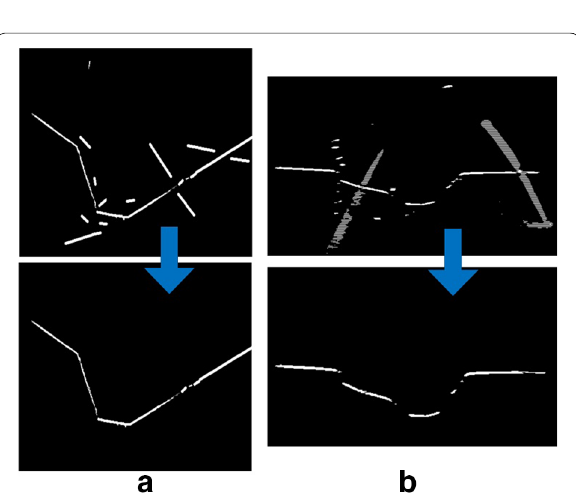
Figure 12 WSPE to show the anti-interference ability of the proposed method: a WSPE result for T-joints from survival interference data points that are manually added, b WSPE result for butt joints from survival interference data points after